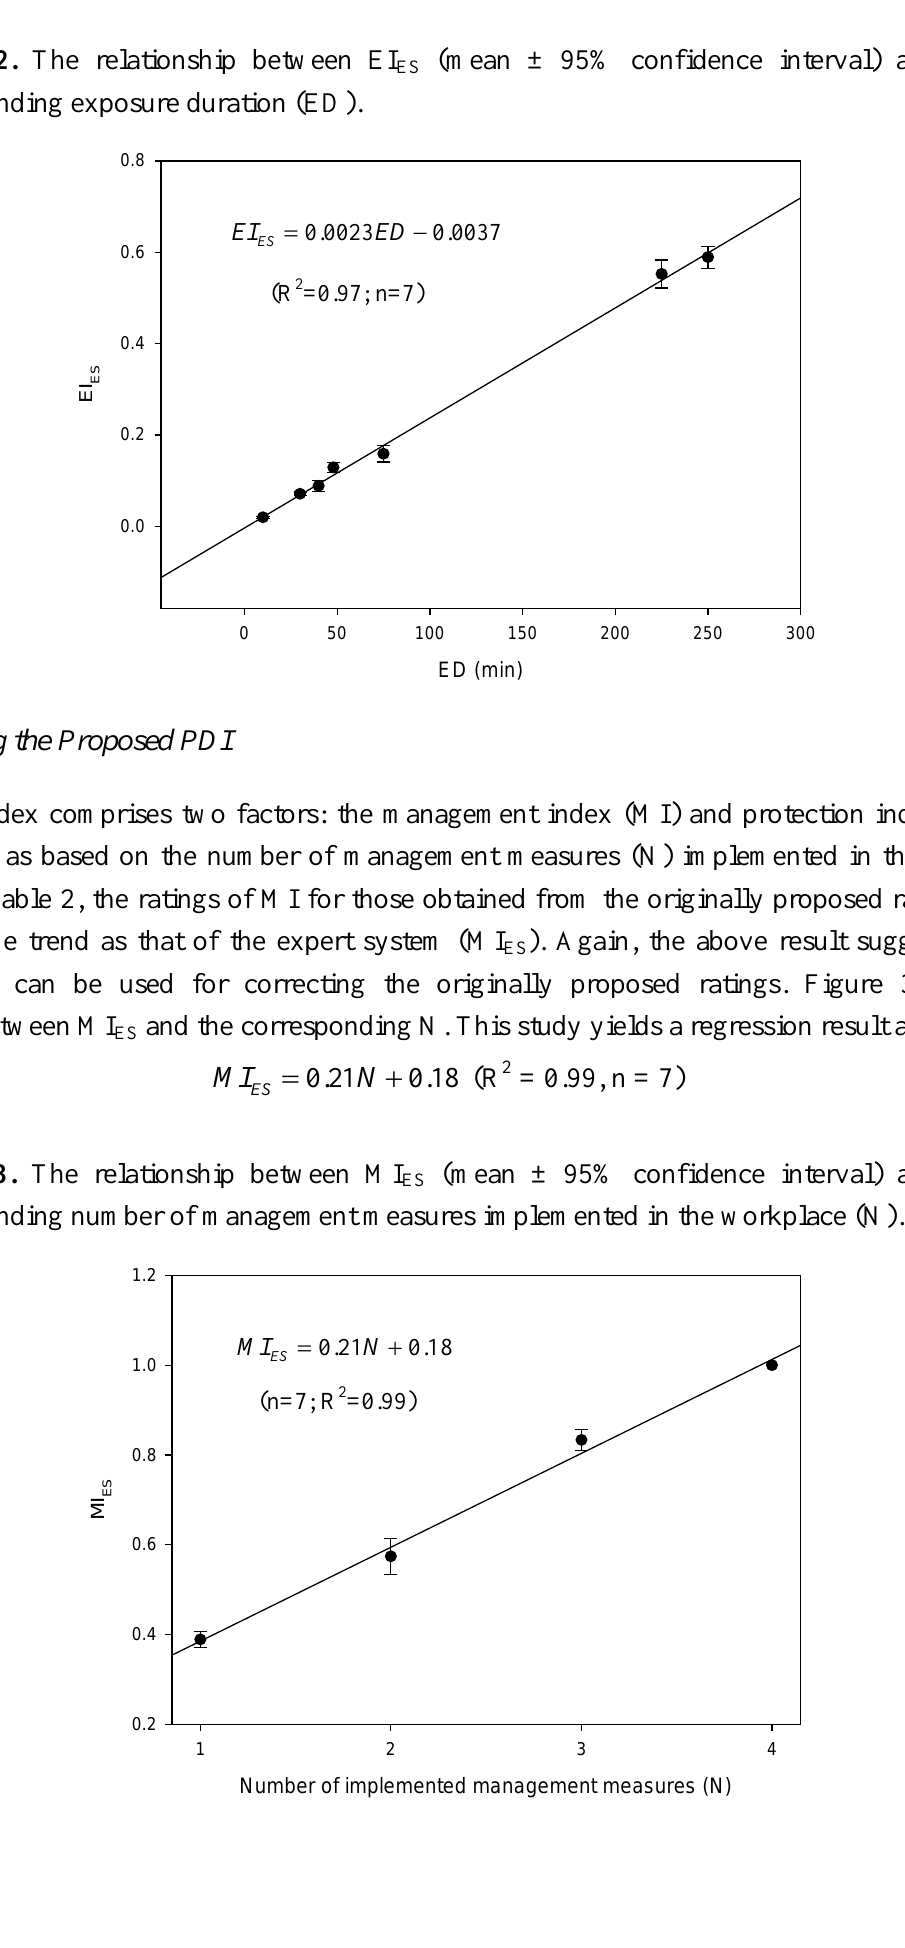
(mean ± 95% confidence interval) and the ES